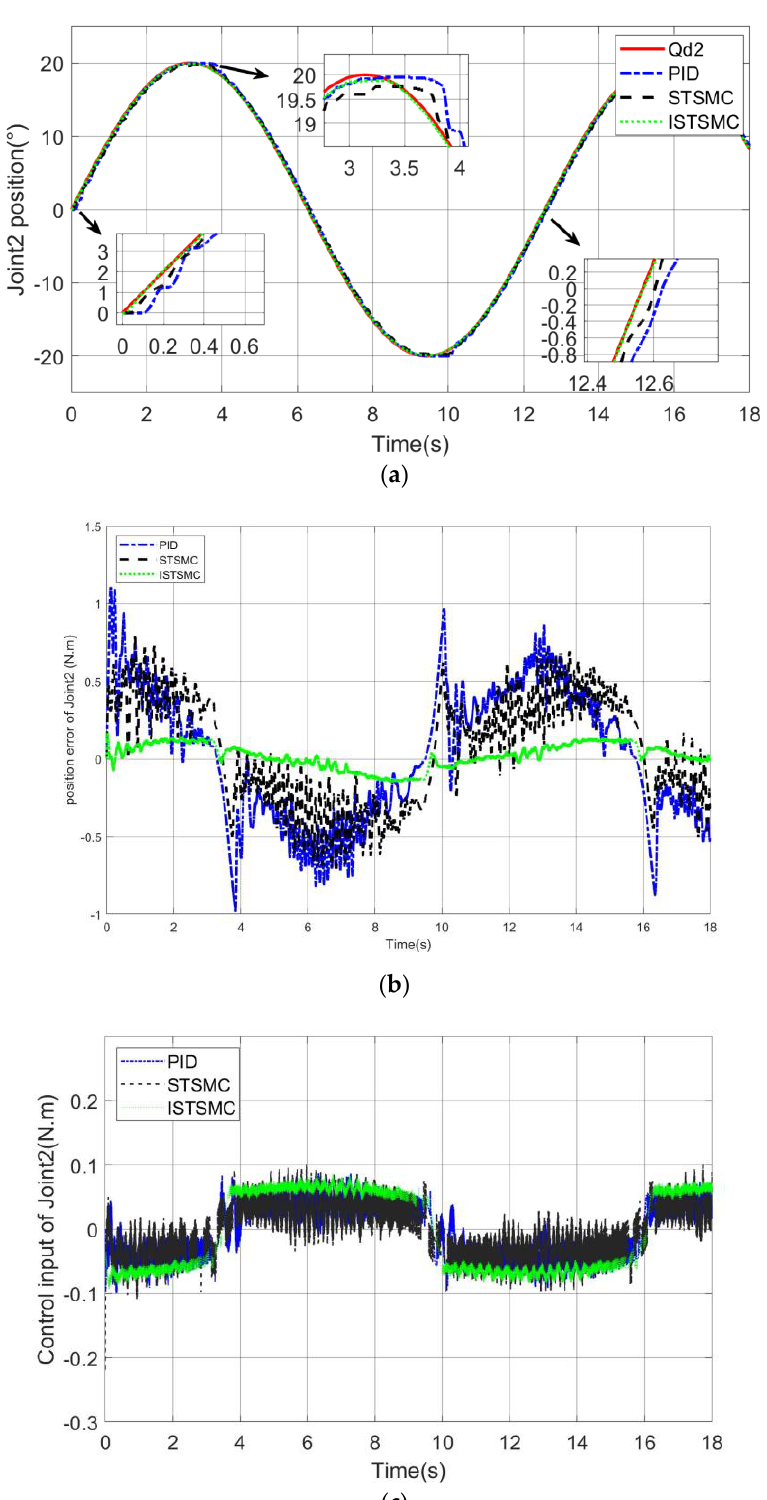
Figure 6. Joint 1 under sine. ( a ) Trajectory tracking diagram; ( b ) trajectory tracking error diagram; ( c ) control input diagram.